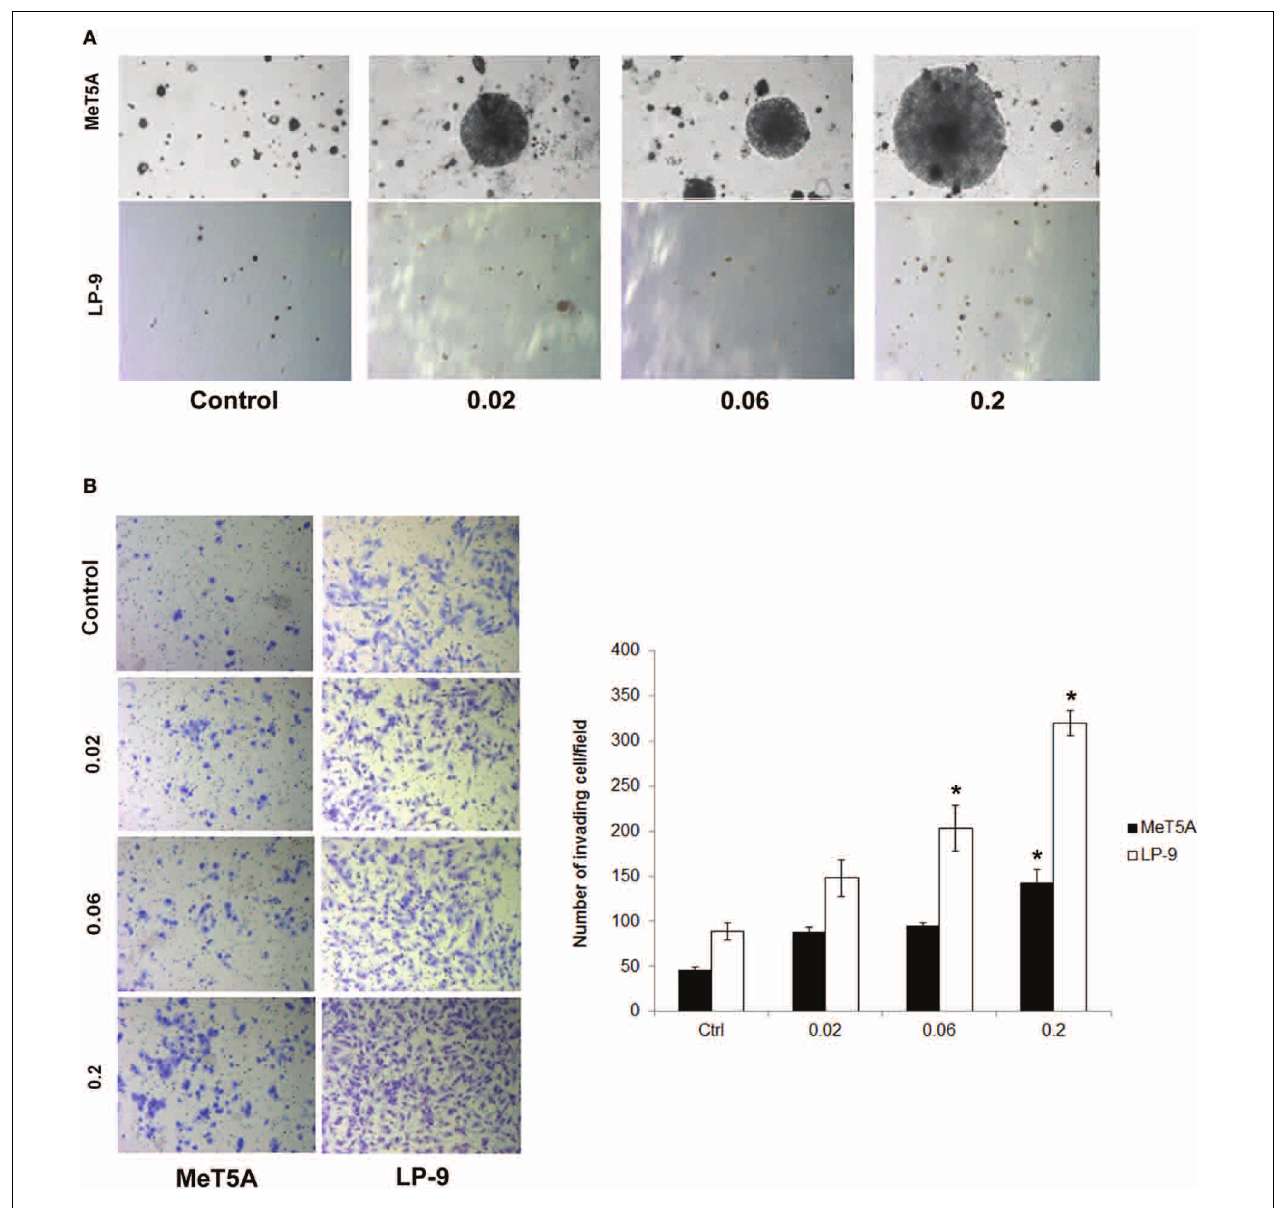
FIGURE 1 | Cancer hallmark transformation phenotypes of SWCNT-exposed MeT-5A and LP-9 cells. Anchorage-independent cell growth was determined by soft agar colony formation assay. Two-month exposed MeT-5A and LP-9 cells in culture medium containing 0.33% agar were plated onto the dish coated with 0.5% agar in culture medium. Colonies